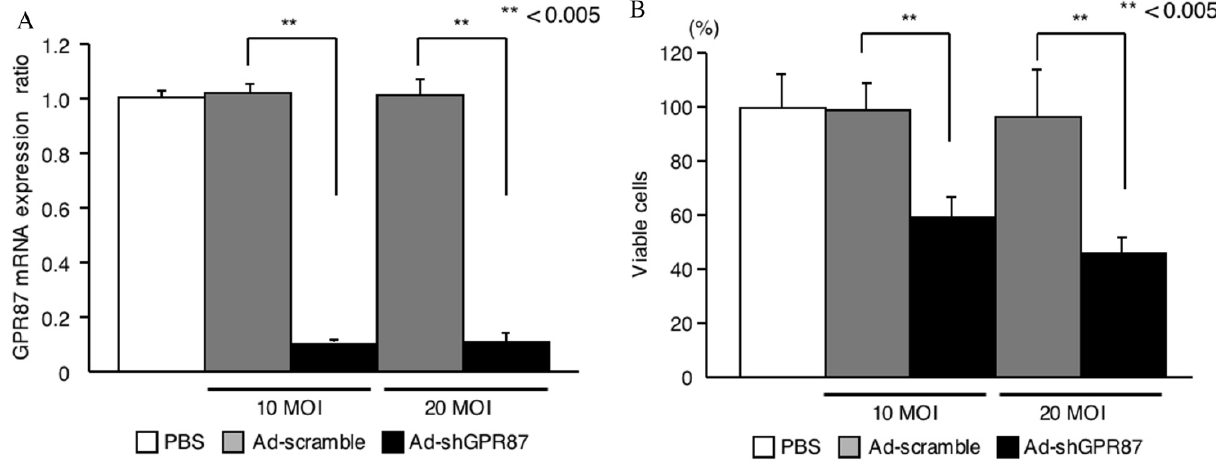
Figure 2. Suppressive effect of Ad-shGPR87 on GPR87 gene expression ( A ) and cellular viability ( B ) in human bladder cancer HT1197 cells. The error bars indicate standard